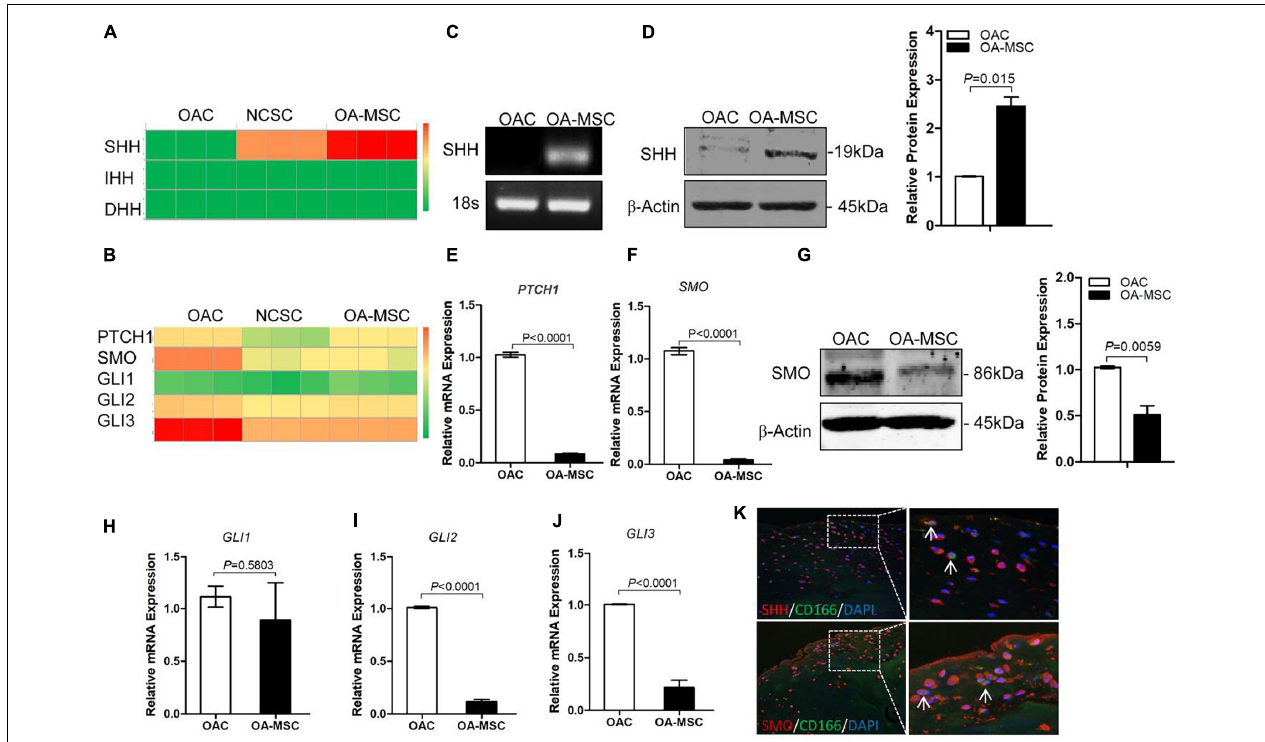
FIGURE 1 | Sonic Hedgehog ( SHH ) was synthesized by human cartilage mesenchymal stromal cell (MSC) while hedgehog (HH) receptors and transcription factors were expressed by human chondrocyte. (A) Heat map of copy numbers of transcripts encoding HH ligands ( SHH, IHH, DHH ) in osteoarthritic chondrocytes (OAC), normal cartilage stromal cells (NCSC), and osteoarthritis mesenchymal stromal cell (OA-MSC). (B) Heat map of copy numbers of transcripts encoding HH receptors ( PTCH1, SMO ) and transcription factors ( GLI1, GLI2, GLI3 ). (C) Real-time RT-PCR analysis validated the upregulation of SHH transcript in OA-MSC. Total RNA was isolated from primary human OAC and OA-MSC. 18S RNA was used as RT-PCR and loading control. Data are representative of three independent experiments. (D) Western blot analysis and quantification indicated SHH protein was abundantly expressed by OA-MSC but not OAC. β -actin was used as Western blot analysis and protein loading control. Molecular weight of proteins was indicated. Relative levels of SHH protein expression in OA-MSC are shown in the bar graph ( n = 3). Real-time RT-PCR analysis validated the up-regulation of PTCH1 transcript (E) and SMO transcript (F) in OAC. Total RNA was isolated from primary human OAC and OA-MSC. 18S RNA was used as a normalizing control ( p < 0.0001). (G) Western blot analysis and quantification indicated SMO protein was down-regulated in OA-MSC. β -actin was used as Western blot analysis and protein loading control. Molecular weight of proteins is indicated. Relative levels of SHH protein expression in OA-MSC are shown in the bar graph ( n ≥ 4). Real-time RT-PCR analysis validated the expression of GLI1 transcript (H) , GLI2 transcript (I) , and GLI3 transcript (J) in OAC and OA-MSC. Total RNA was isolated from primary human OAC and OA-MSC. 18S RNA was used as a normalizing control ( n ≥ 4). (K) Double immunofluorescence histochemical analysis of human osteoarthritis (OA) articular cartilage with anti-sonic hedgehog antibody (rhodamine red), anti-CD166 (cartilage MSC marker) antibody (fluorescein green), and Hoechst nuclei dye (DAPI blue). SHH protein was distributed in CD166-positive OA-MSC cells which synthesized SHH (arrows). SHH protein was also distributed in CD166-negative OACs which SHH bound. SMO protein was distributed in CD166-negative chondrocytes (arrows). The images shown are representative of multiple tissue samples ( n = 3). Scale bar = 125 µ